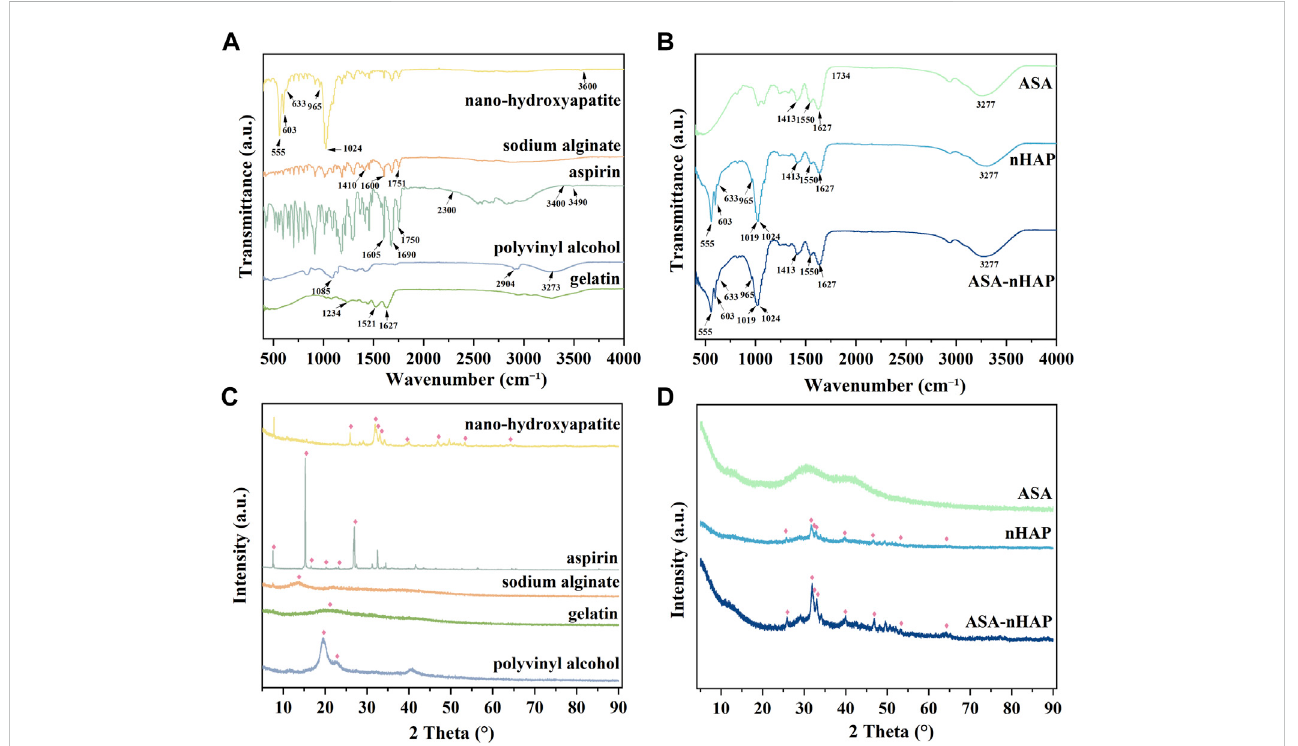
FIGURE 1 Chemical constitution and crystal structure analysis of the raw powders and the composited hydrogel scaffolds. (A) The FTIR spectra of nanohydroxyapatite, aspirin, sodium alginate (SA), gelatin (Gel), and polyvinyl alcohol (PVA). (B) The FTIR spectra of ASA/PVA/Gel/SA (ASA group), nHAP/PVA/ Gel/SA (nHAP group), and ASA-nHAP/PVA/Gel/SA (ASA-nHAP group) hydrogel scaffold. (C) The XRD pattern of nanohydroxyapatite, aspirin, sodium alginate (SA), gelatin (Gel), and polyvinyl alcohol (PVA). (D) The XRD pattern of ASA/PVA/Gel/SA (ASA group), nHAP/PVA/Gel/SA (nHAP group), and ASA-nHAP/ PVA/Gel/SA (ASA-nHAP group) hydrogel